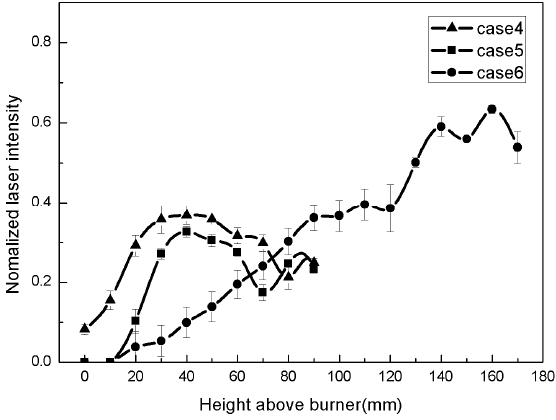
Figure 9. Axial variation of soot volume fractions at the centerline of three different flames.